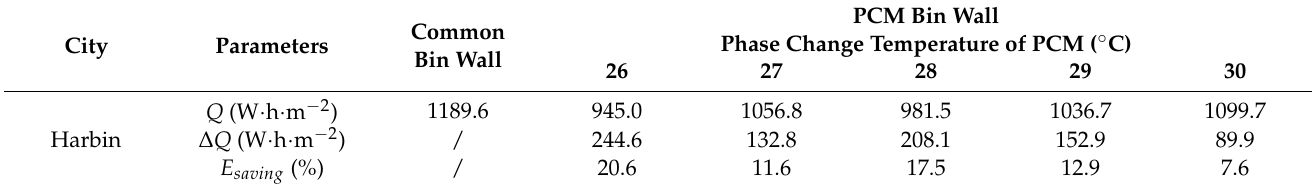
Table 4. Weekly heat gain and energy saving results with different T m for cold grain storage